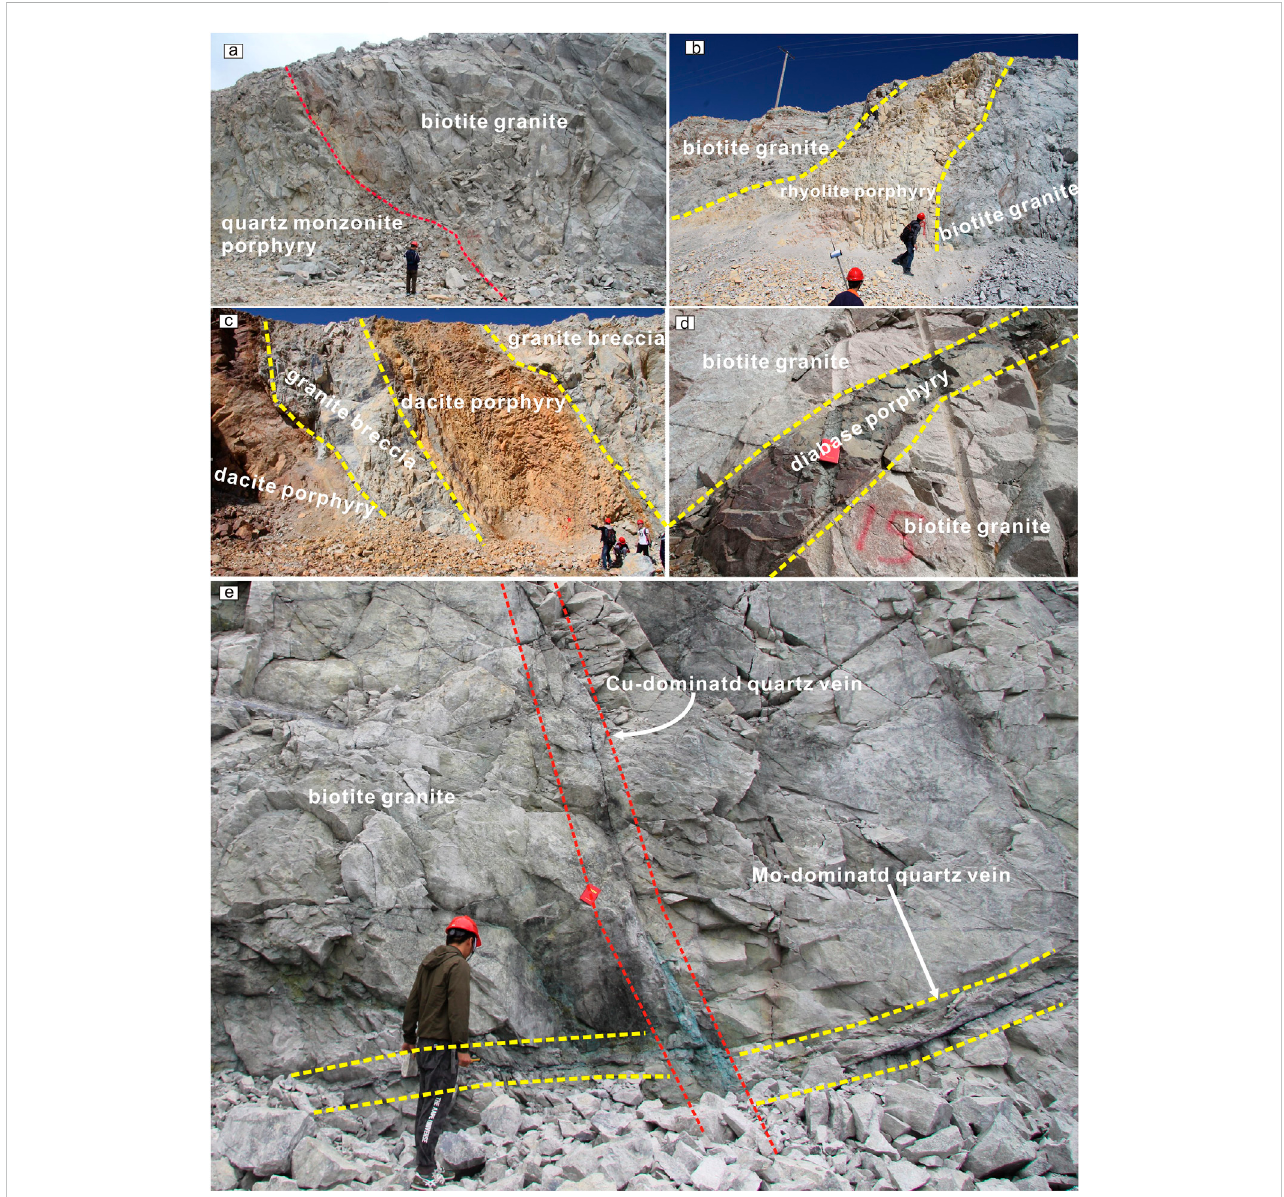
FIGURE 3 Field photographs of magmatic rocks and quartz veins in Wunugetushan porphyry Cu-Mo deposit. (A) quartz monzonite porphyry has a contact with biotite granite by fault; late (B) rhyolite porphyry, (C) dacite porphyry and (D) diabase porphyry dikes distribute along the faults or cracks within biotite granite. (E) Mo-dominated quartz vein is cut by late Cu-dominated quartz